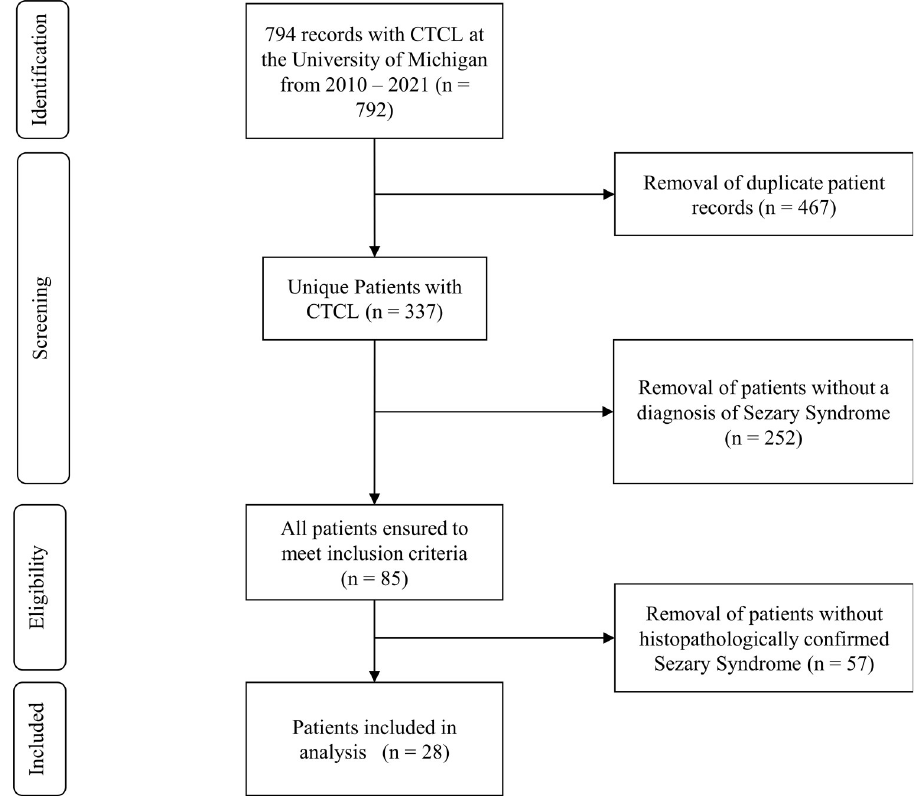
Fig 1. Flow diagram detailing inclusion and exclusion of patients at each stage of the